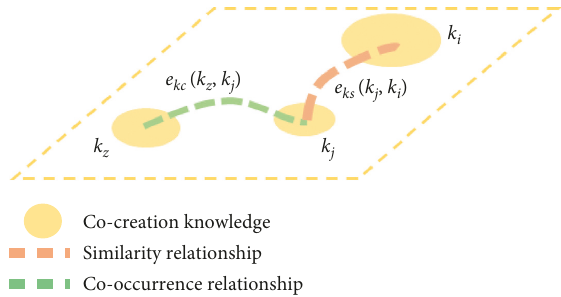
Figure 5: Co-creation knowledge